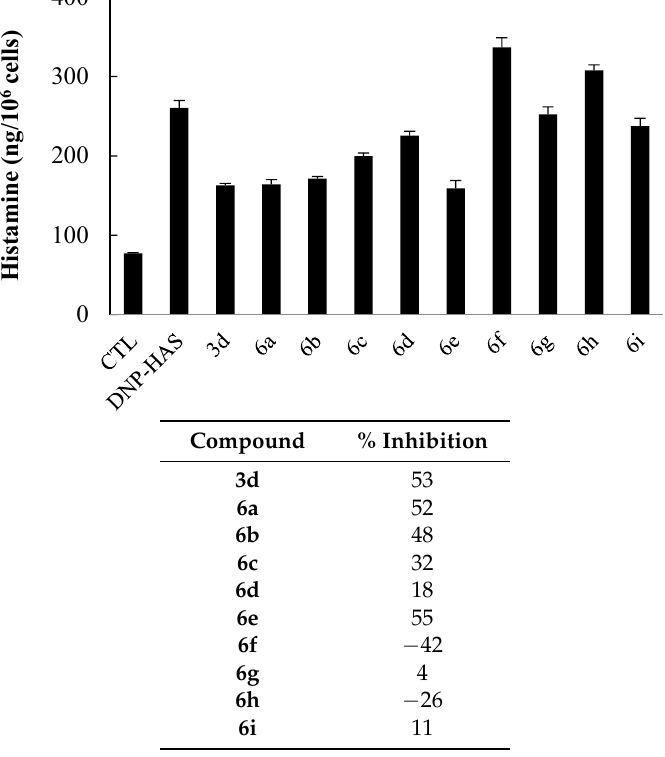
Molecules 2017 , 22 , 898 Table 4. Inhibitory activity of 3d and its analogs (10 nM) on histamine release in RBL-2H3 cells.